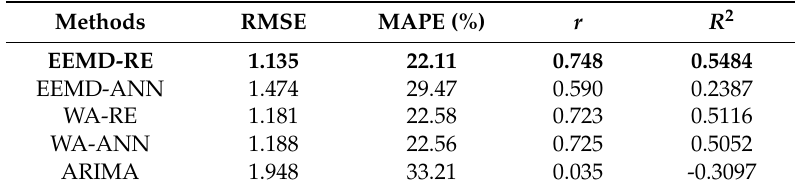
Table 1. Predictive accuracy of different models with daily data.